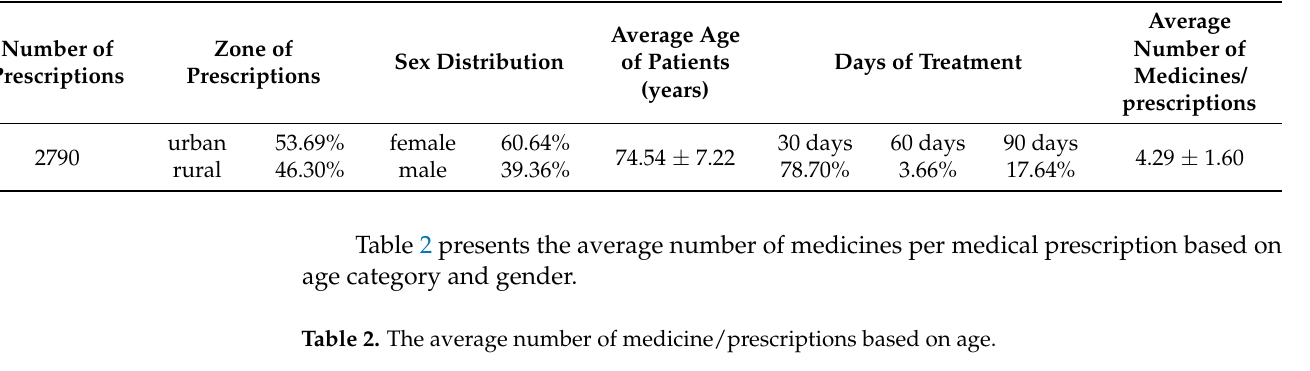
Table 1. Main characteristics of the analyzed prescriptions and patients.